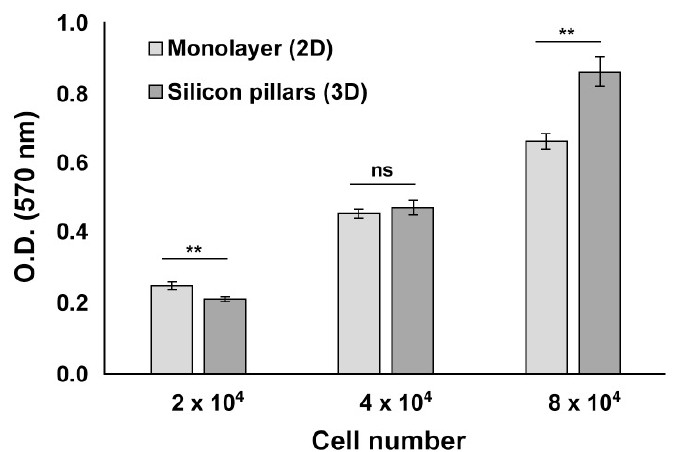
Figure 3. hCPs seeded on silicon micropillar arrays maintain their viability. MTT assay performed on hCPs plated on 3D silicon slide and in standard 2D monolayer shows that hCPs efficiently maintain their viability. Different cell densities were assessed 48 h after seeding. p < 0.01(**), not significant (ns).